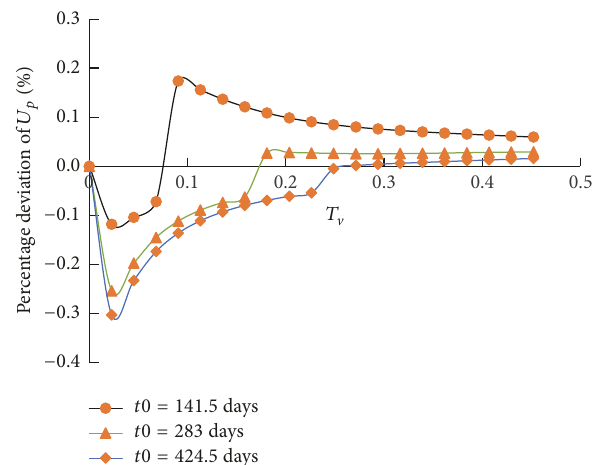
Figure 9: Percentage deviation of 𝑈 𝑝 between the FAM and the semianalytical solution versus 𝑇 V curves for trapezoidal cyclic